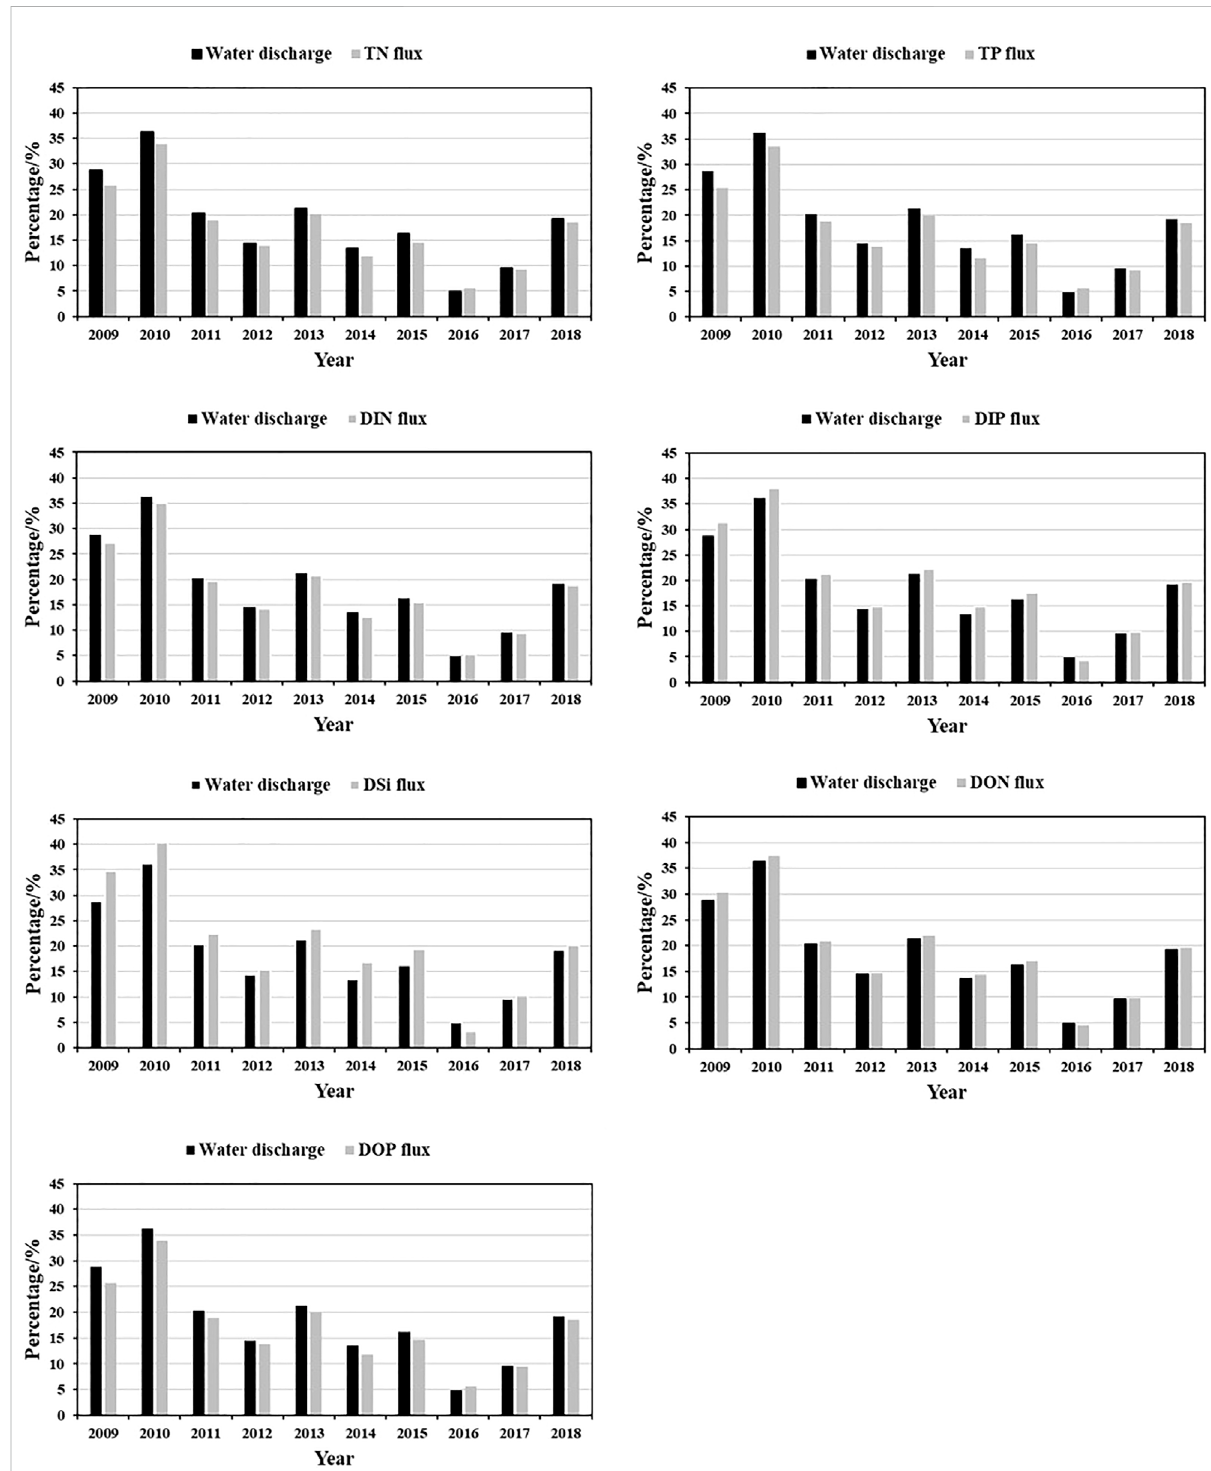
FIGURE 8 Proportionsofwaterdischargeandnutrient fl